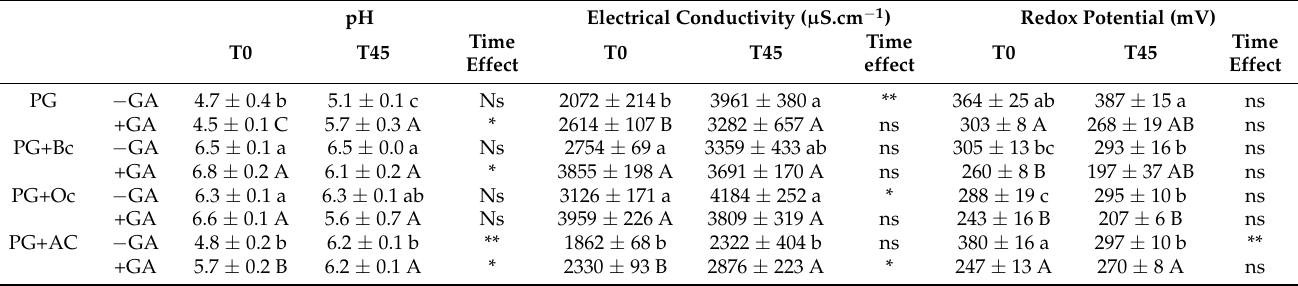
Table 1. Soil pore water physicochemical properties (pH, electrical conductivity ( µ S.cm − 1 ) and redox potential (mV)) determined at the beginning (T0) and at the end of the experiment (T45) in Pontgibaud technosol alone (PG) or amended with biochar (PG+Bc), ochre (PG+Oc) and activated carbon (PG+AC), associated or not with green amendment (+/ − GA). Small letters indicate a significant difference between the treatments without green amendment while capital letters indicate a significant difference between the conditions with the green amendment ( p < 0.05) (n = 5 ± SE). pH Electrical Conductivity ( µ S.cm − 1 ) Redox Potential (mV)